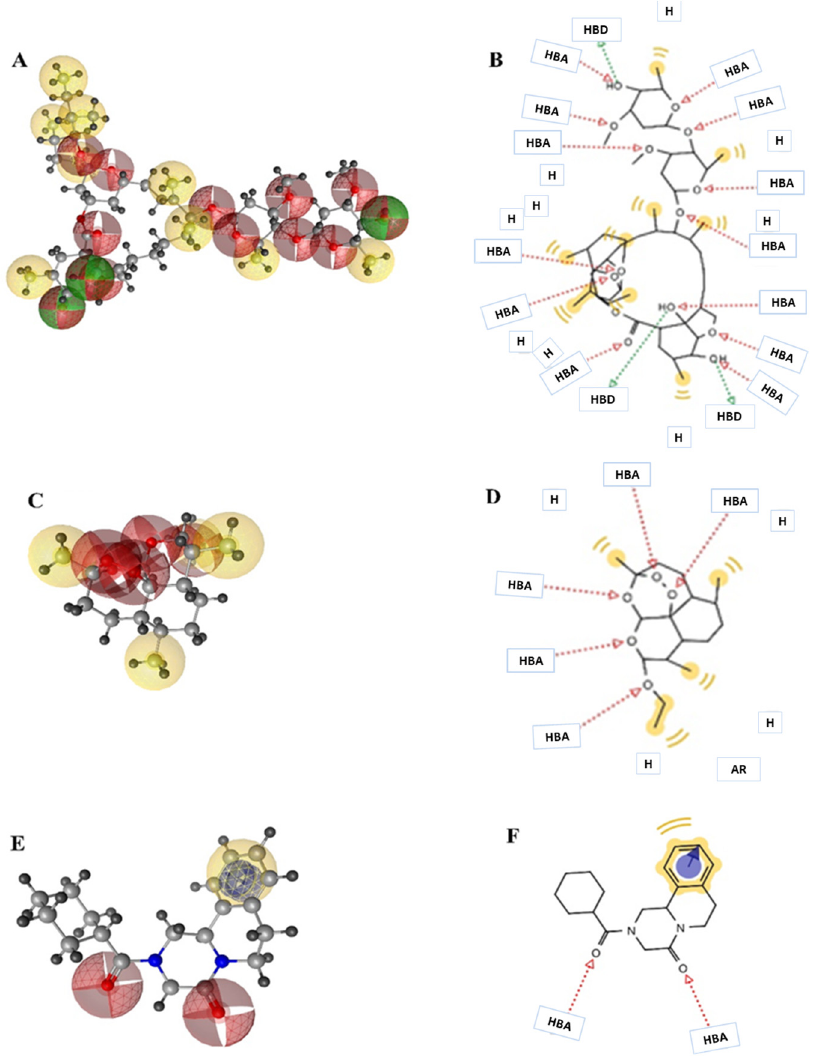
Figure 2. Three-dimensional ( A , C , E ) and two-dimensional ( B , D , F ) poses displaying the pharmacophore features of ivermectin, arteether and praziquantel. Green arrows show the H-bond donor (HBD); red arrows show H-bond acceptor (HBA) and yellow colours shows hydrophobic group (H) .